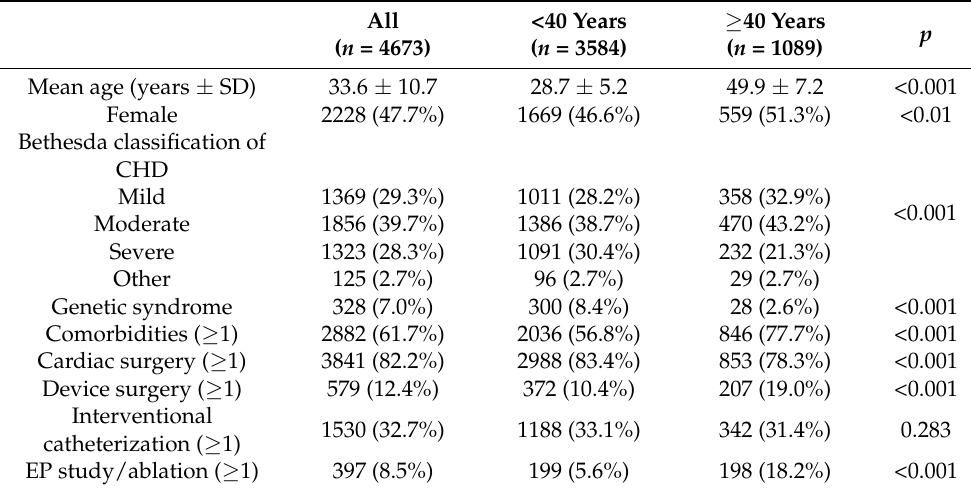
Table 1. Baseline